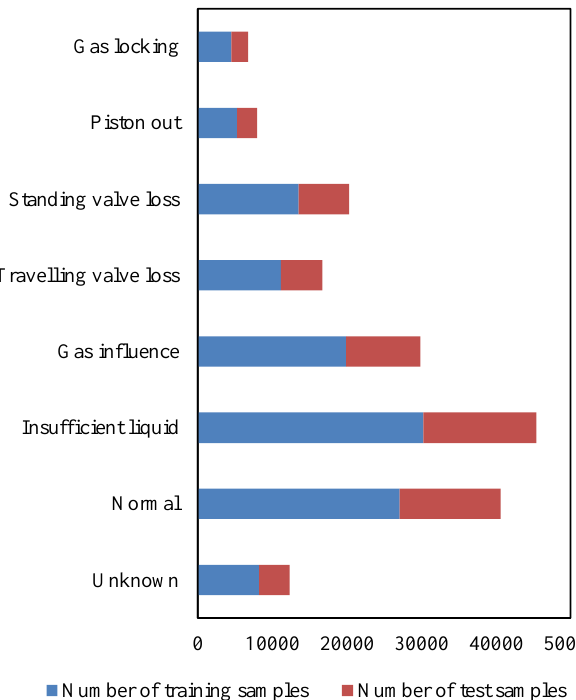
Figure 5—Distribution of experiment